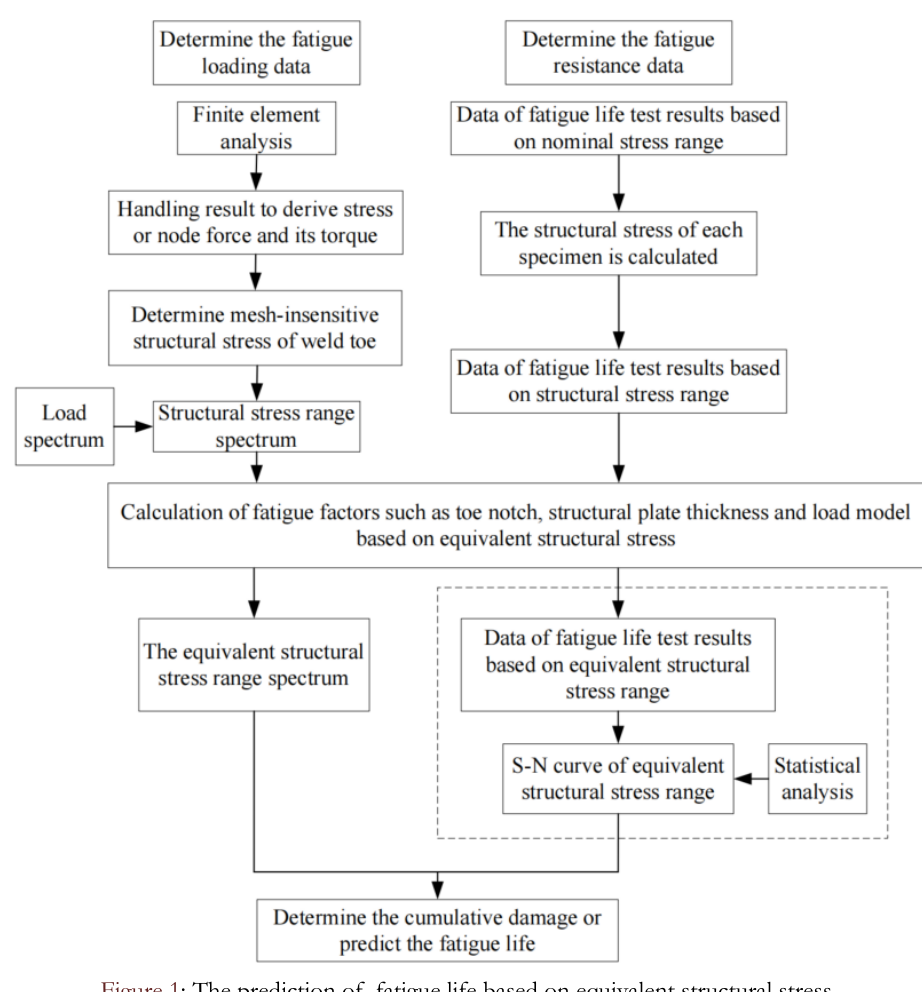
Figure 1: The prediction of fatigue life based on equivalent structural